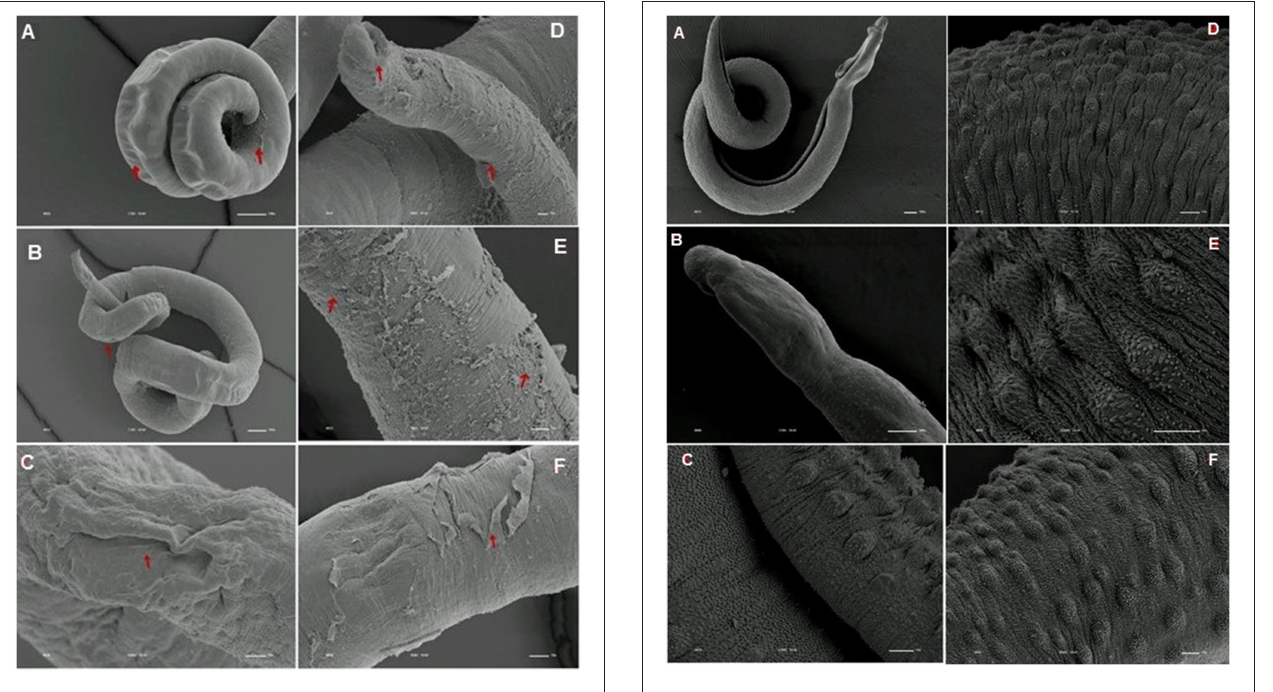
FIGURE 8 | Scanning electron microscopy of S. mansoni PZQ-susceptible strain adult females after exposure to 0.3 µ M of PZQ for 3 h. (A–C) Susceptible strain adult females upon exposure to PZQ, showing muscle contraction and corrugations; (D) alterations in oral sucker; (E,F) peeling of some tegumental regions. Red arrows indicate alterations. Image marginations: (A) 170x 10 kV ________100u; (B) 110x 10 kV ________100u; (C) 1000x 10 kV ________10u; (D) 500x 10 kV ________10u; (E) 900x 10 kV ________10u; (F) 950x 10 kV ________10u.